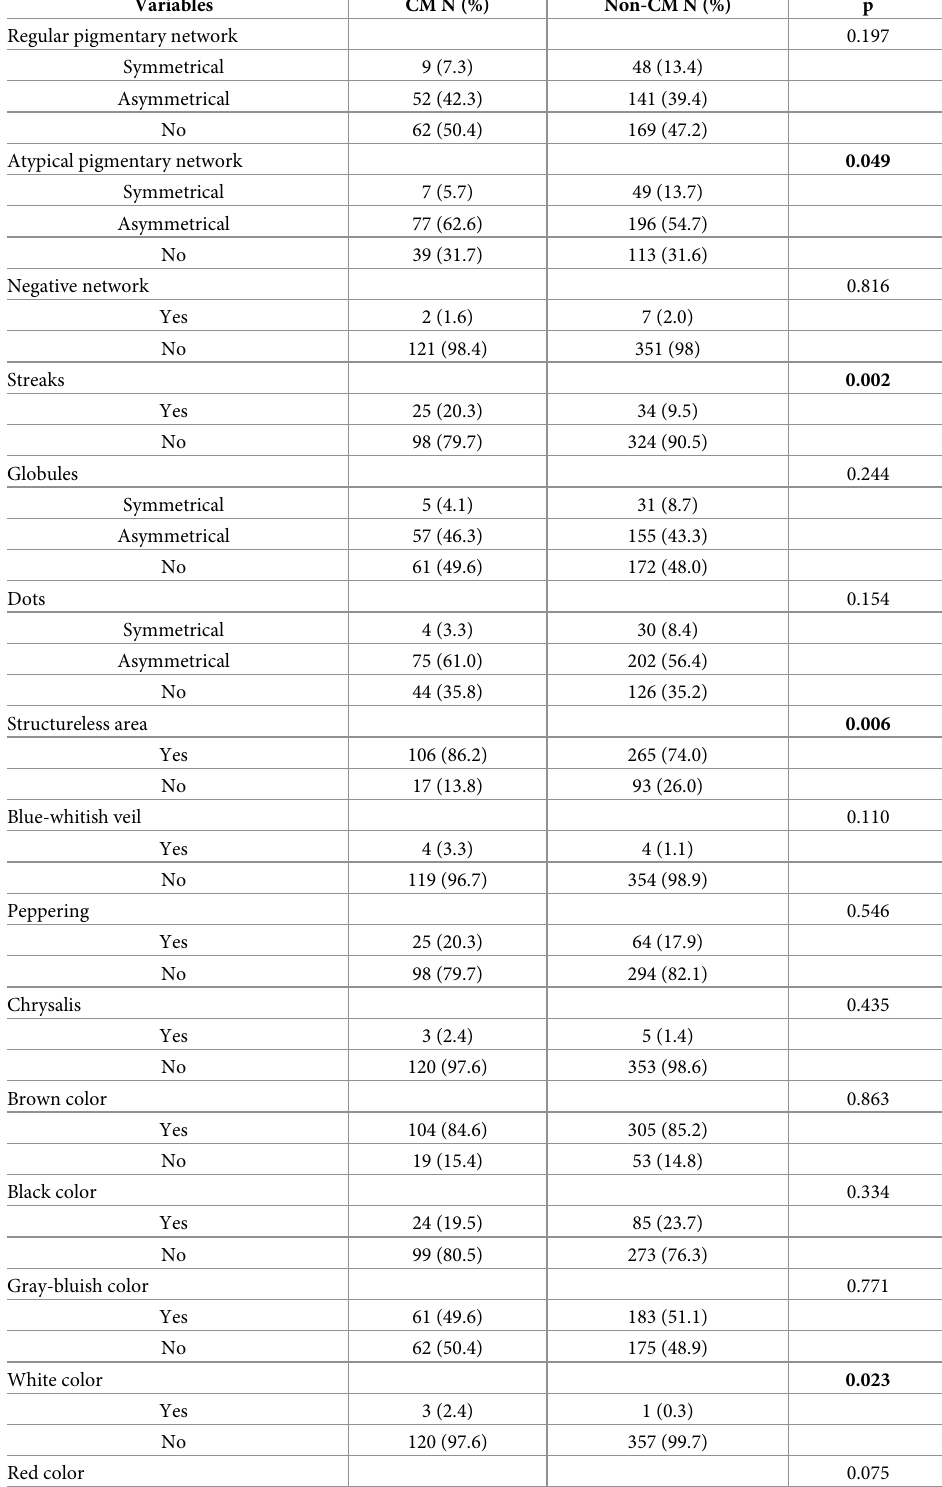
Table 2. Dermatoscopic characteristics of 481 melanocytic lesions � 6mm in